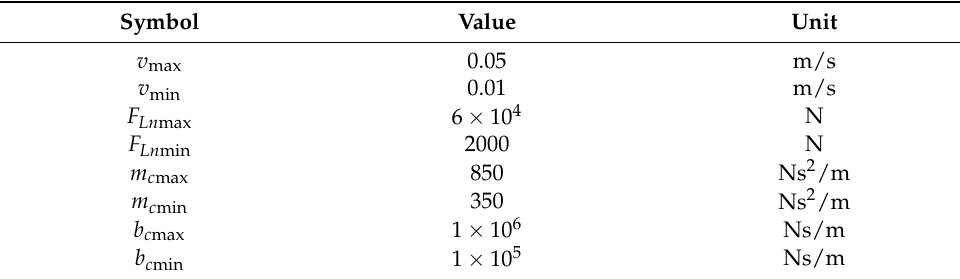
Table 6. Parameters of the fuzzy impedance rule.